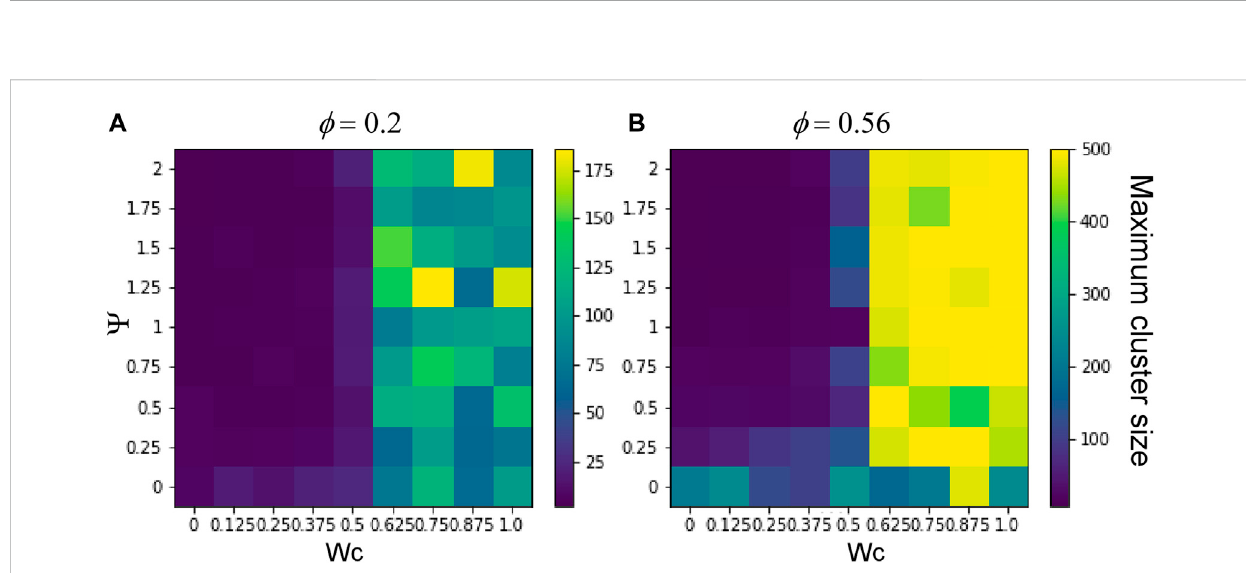
FIGURE 5 MaximumclustersizeasafunctionofCILandcell – celladhesion.Themaximumclustersizesforthe fi nalstates(after500timesteps,eachgridpoint representstheaverageof25simulations)ofsimulationswithcelldensitiesof (A) ϕ (cid:1) 0.2(500cellsonasphereofradius25)and (B) ϕ (cid:1) 0.56(500cellsona sphere of radius 15). Clustering is increased by high cell – cell adhesion (W c ). Both high and low levels of CIL ( Ψ ) decrease cell clustering. The plots are the averages of 25 independent